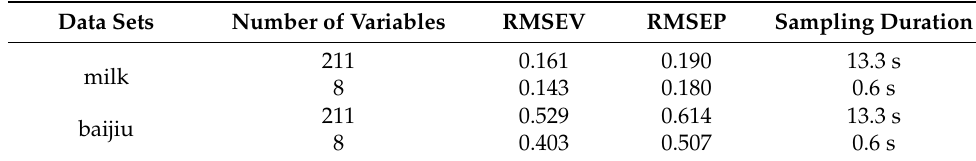
Table 7. The performance of the system for two